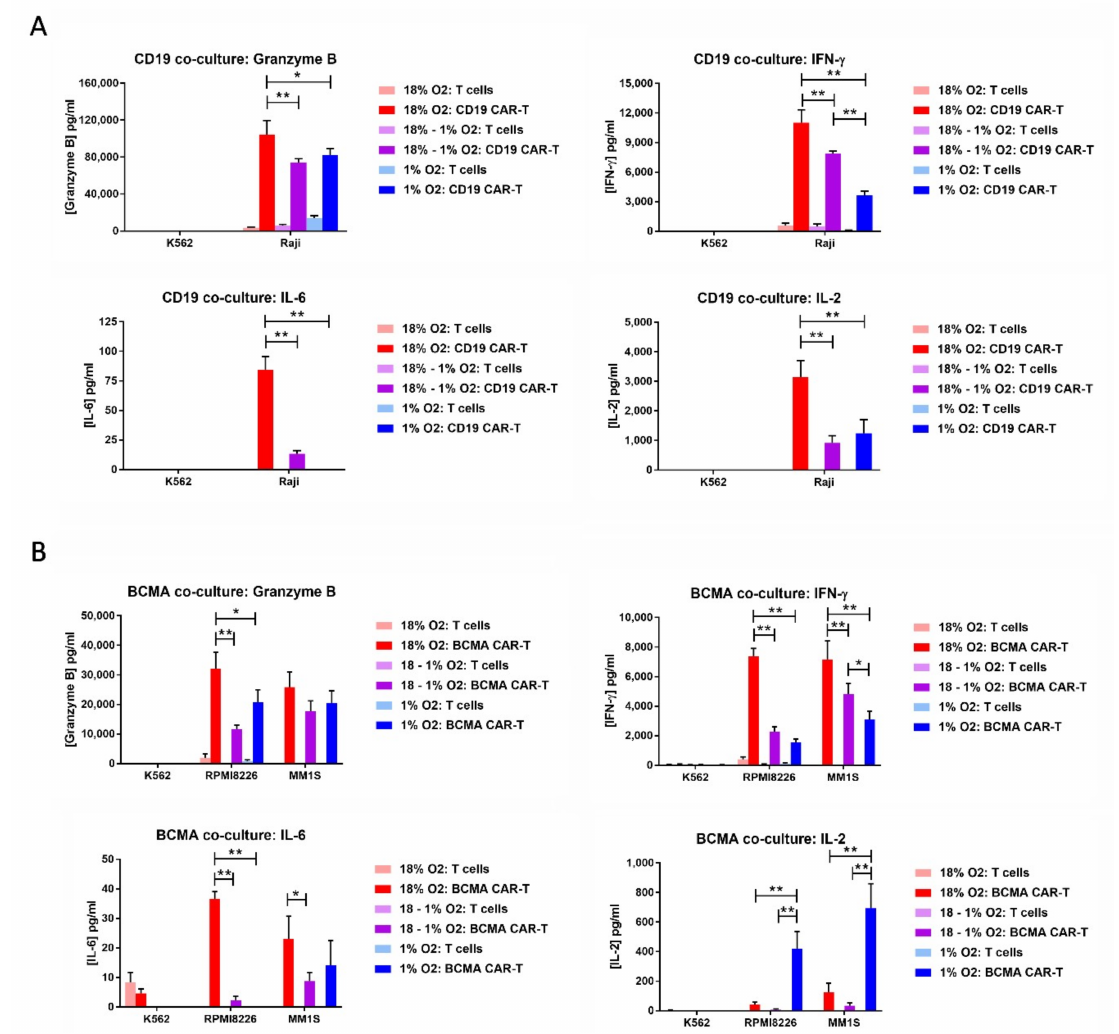
Figure 7. Hypoxia decreases CAR-T cell granzyme B and cytokine production in response to tumor cells. CD19 CAR-T cells or control T cells ( A ) were co-cultured with CD19 + Raji cells or CD19 − K562 cells. BCMA CAR-T cells or control T cells ( B ) were cultured with BCMA + RPMI8226 cells, BCMA + MM1S cells or BCMA – K562 cells. The medium from the co-cultures was analyzed by ELISA for the levels of granzyme B, IFN- γ , IL-2, and IL-6. Data-points represent the average and standard error of 2-4 separate experiments. * p < 0.05 and ** p <